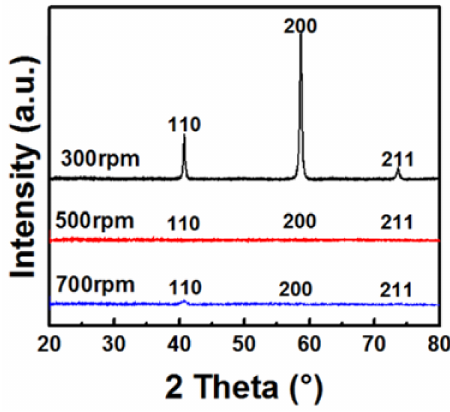
Figure 5. The XRD pattern at 60 h ball-milled tungsten powder with different milling